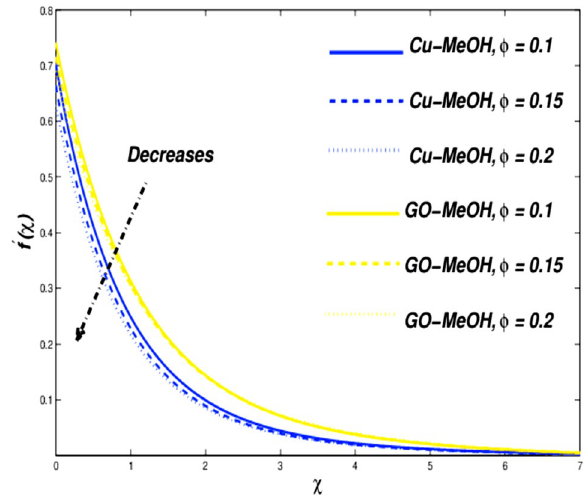
Figure 10. Velocity variation versus φ .